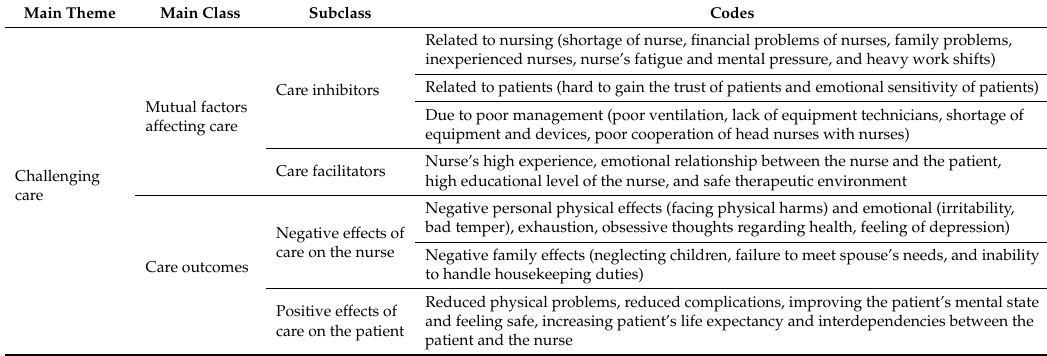
Table 2. Main theme, main classes, and subclasses derived from